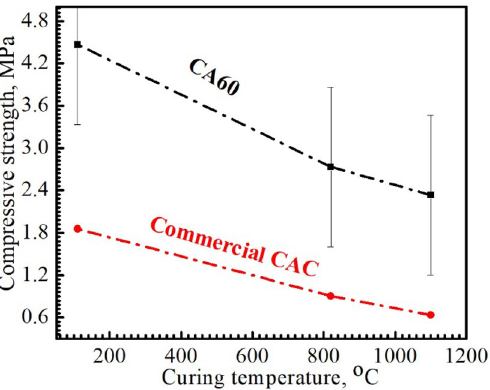
Figure 13. Effect of curing temperature at 110, 820, and 1100 °C, on the crushing strength of